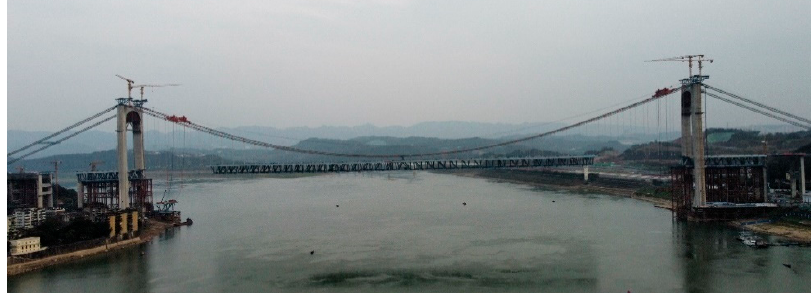
Figure 1. A UAV photo of Guojiatuo Suspension Bridge.